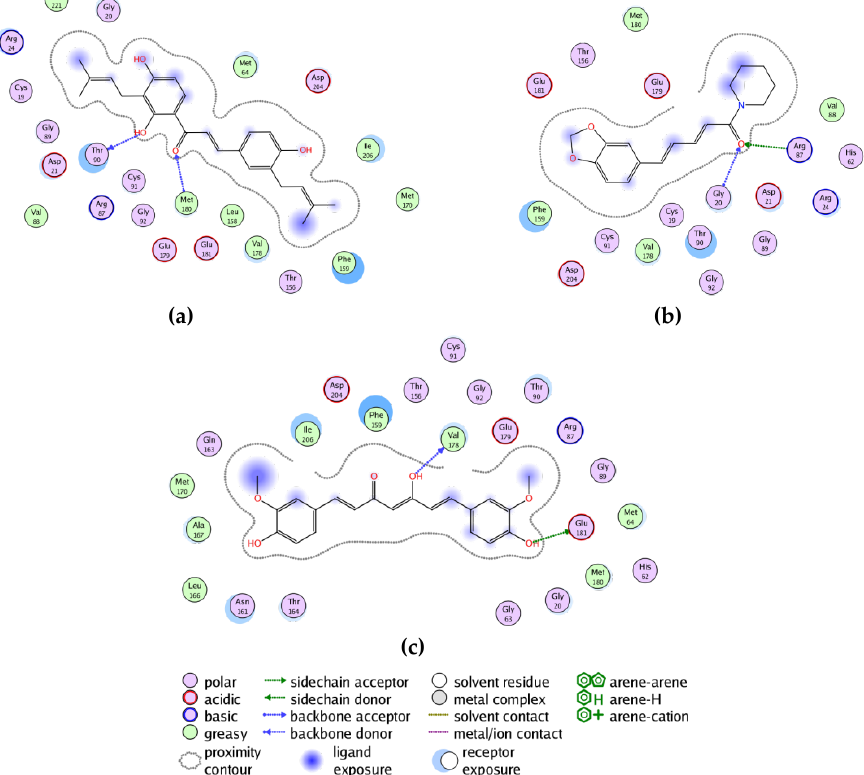
Figure 13. Ligand receptor interaction maps of: ( a ) 2 ′ ,4,4 ʹ -trihydroxy-3,3 ʹ -diprenylchalcone with TvPNP; ( b ) curcumin with TvPNP; and ( c ) piperine with TvPNP.